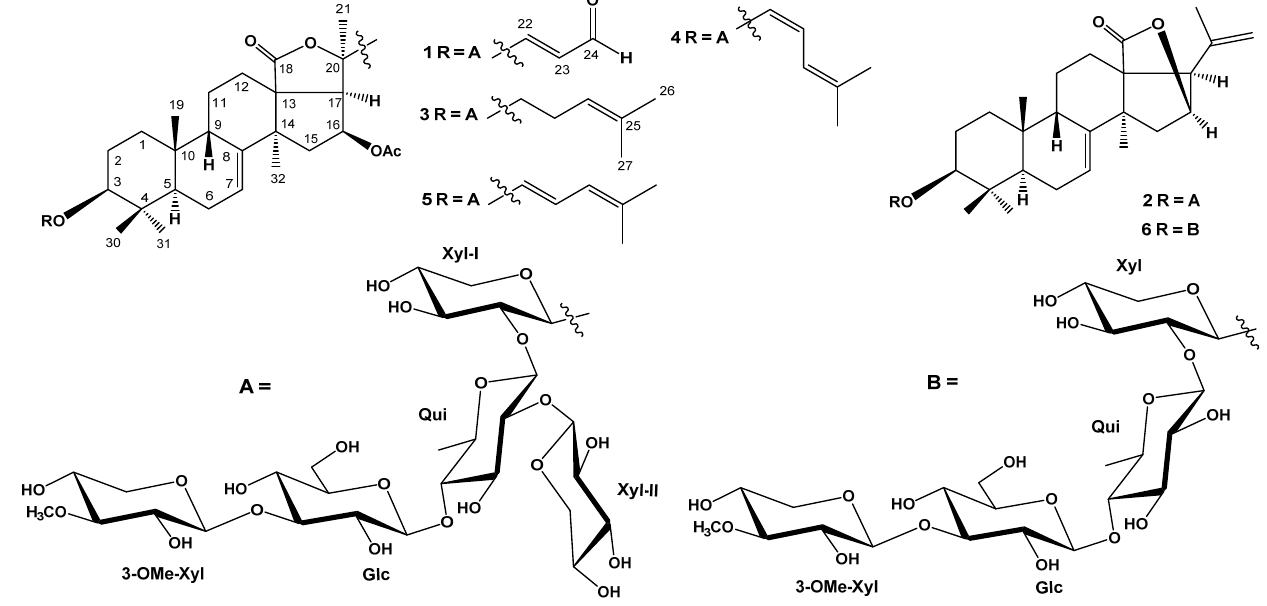
Figure 1. The structures of compounds 1 − 6 isolated from S.